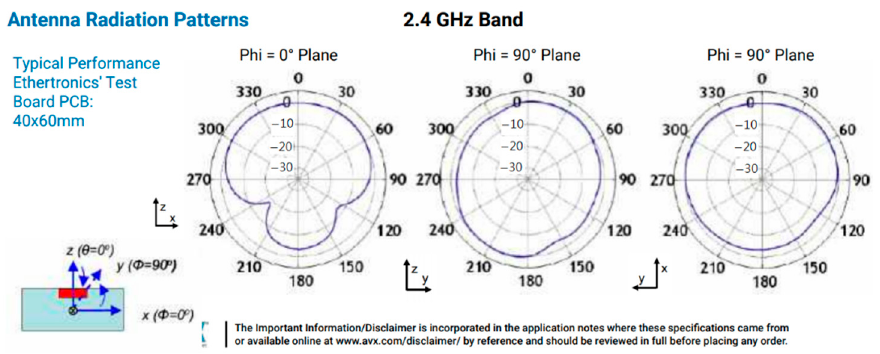
Figure 21. Antenna radiation pattern